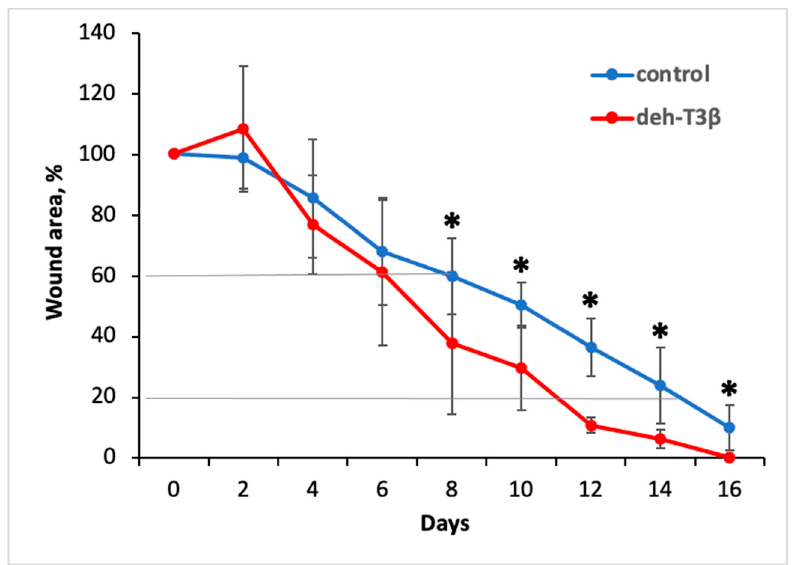
Figure 5. Effect of local treatment with deh-T3 β on wound healing in diabetic db/db mice. The healing rate of full-thickness wounds in db/db mice was promoted by local treatment with 1 µ mol deh-T3 β compared to the vehicle (values are means ± SEM (* p < 0.05, db/db -treated vs. db/db placebo)). Diagonal lines denote 40% healing rate (upper line) after six and eight days for the treated and controls, respectively; and 80% healing rate (lower line) after eleven and fifteen days for treated and controls, respectively.